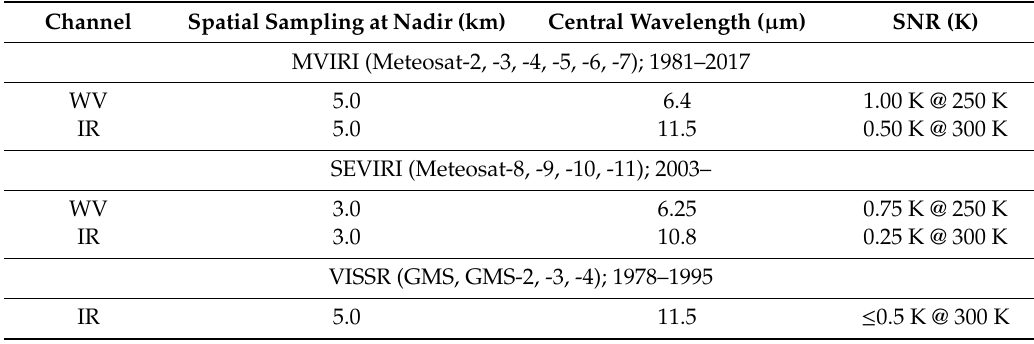
Table 1. Spatial, temporal, spectral and radiometric characteristics of IR and WV channels that are considered in this study. The signal to noise ratio (SNR) values are taken from the WMO OSCAR database and CGMS working paper [15], which are nominal values determined prelaunch, but may not match with the actual radiometric noise of the